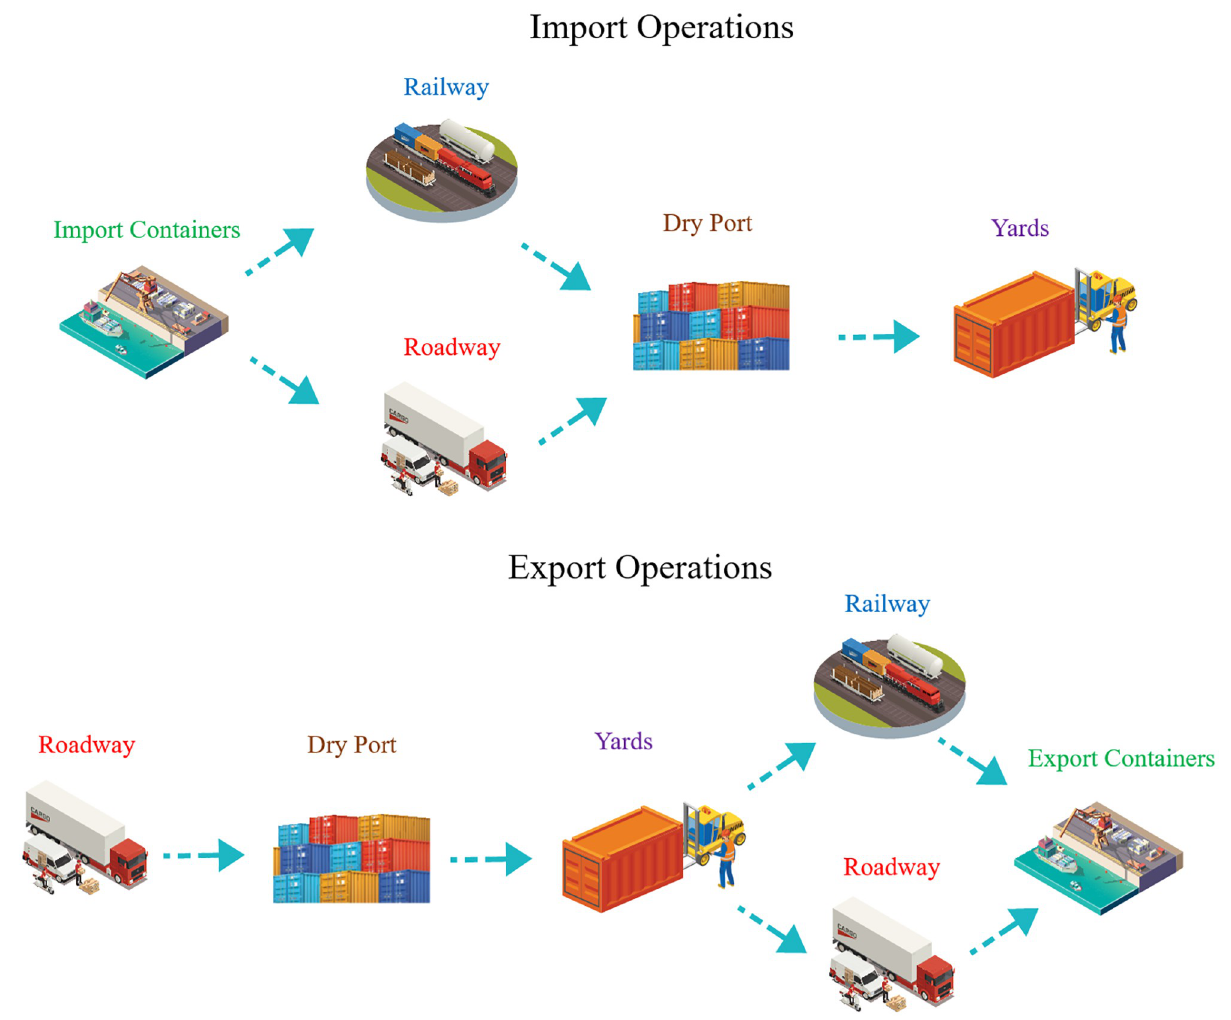
Fig 2. LICD operations for both import and export